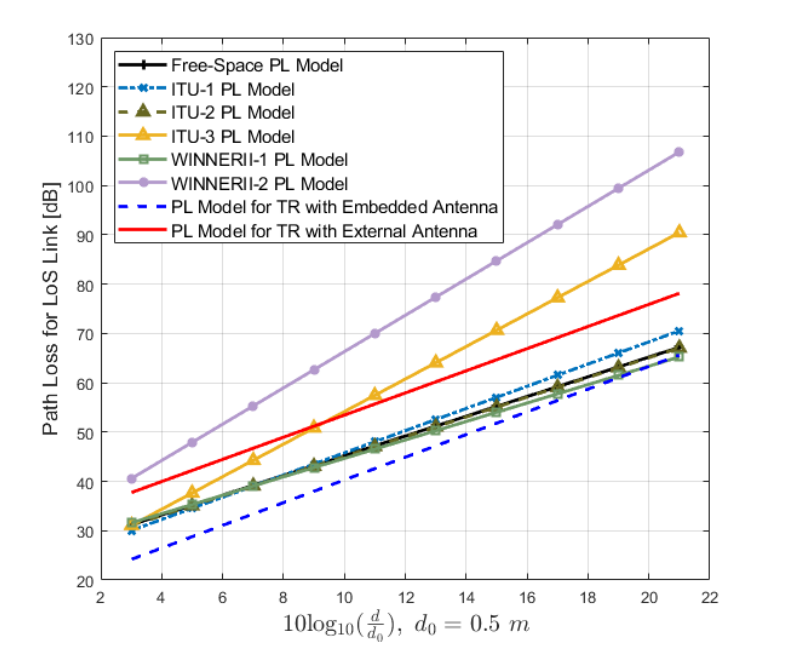
Figure 8. IQRF path loss model comparison with the other model for the Line-of-Sight